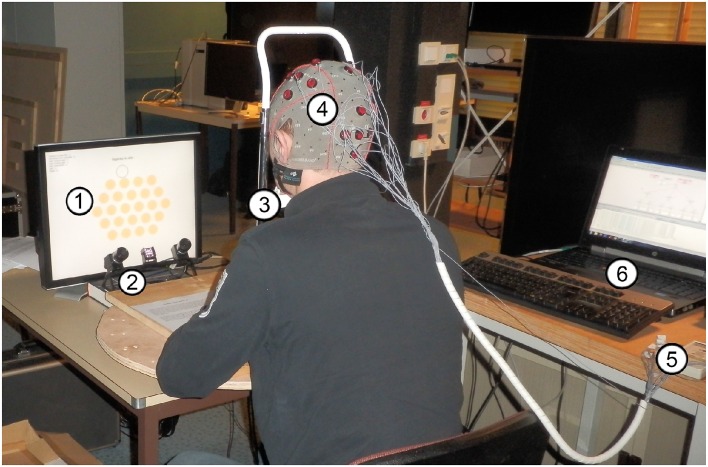
Experimental setup. 1, Visual display; 2, Gaze tracker; 3, Chin rest; 4, EEG headset; 5, EEG signal amplifier; 6, Laptop with Openvibe software for EEG signal processing.